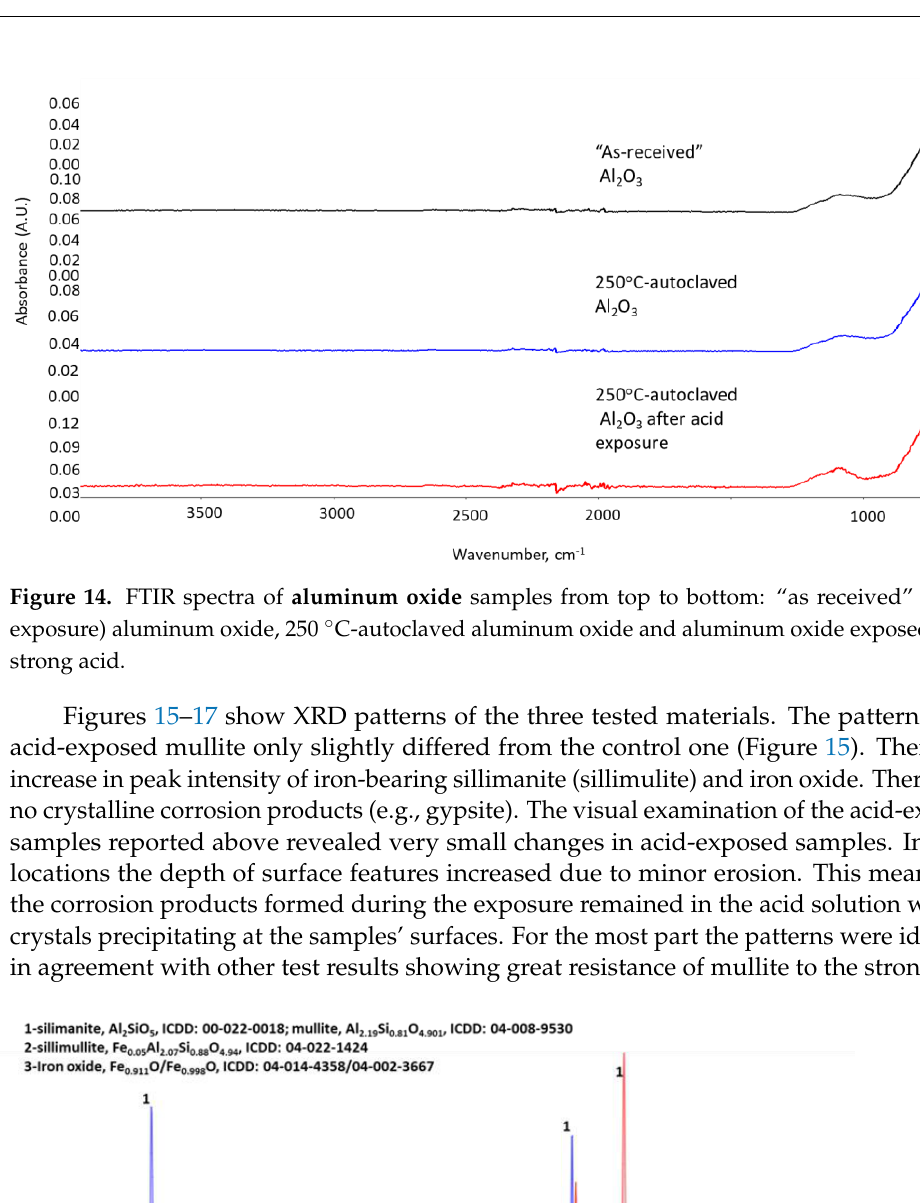
Figure 13. FTIR spectra of anorthite samples from top to bottom: “as received” (before exposure) anorthite, 250 °C-autoclaved anorthite and anorthite exposed to the strong acid.